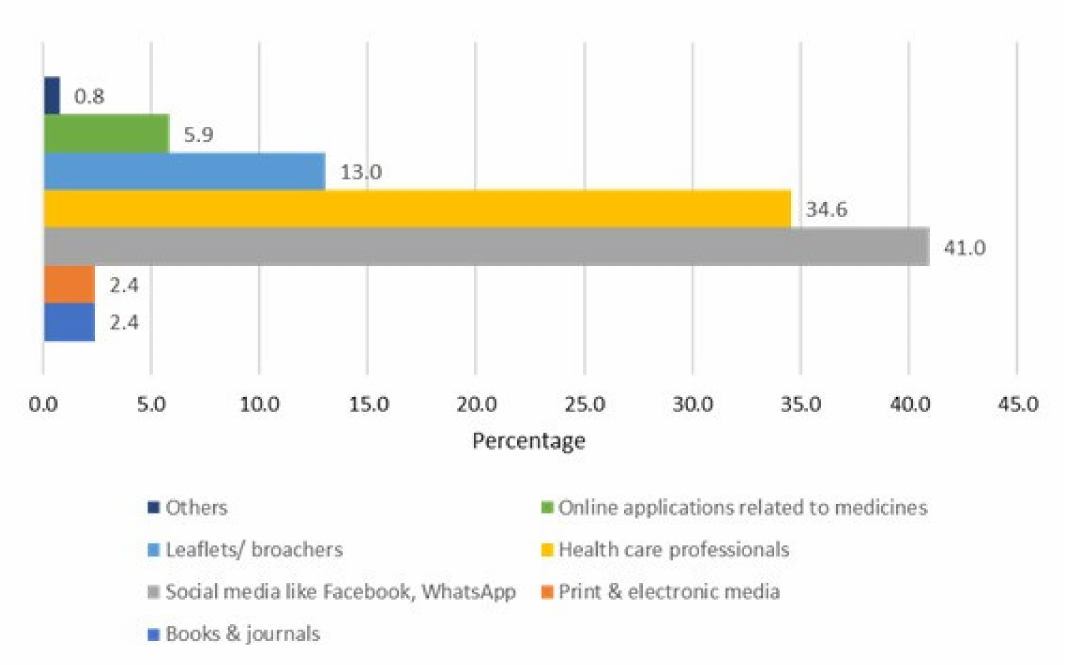
Figure 2. Pharmacy technicians’ sources of information on antibiotic